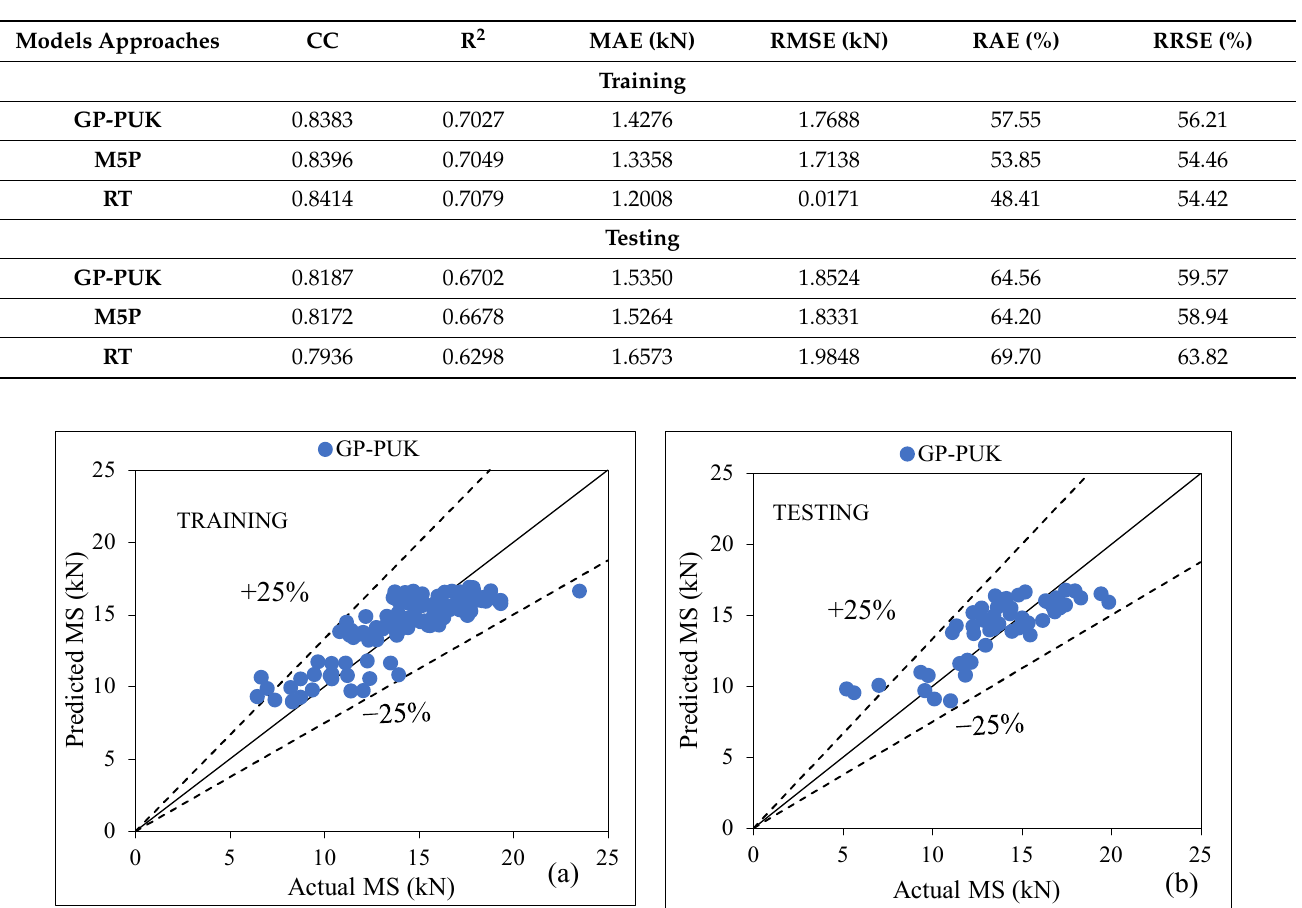
Figure 6. ( a , b ) Agreement graph showing actual vs. predicted values of MS by using a GP-PUK-based model for both stages.